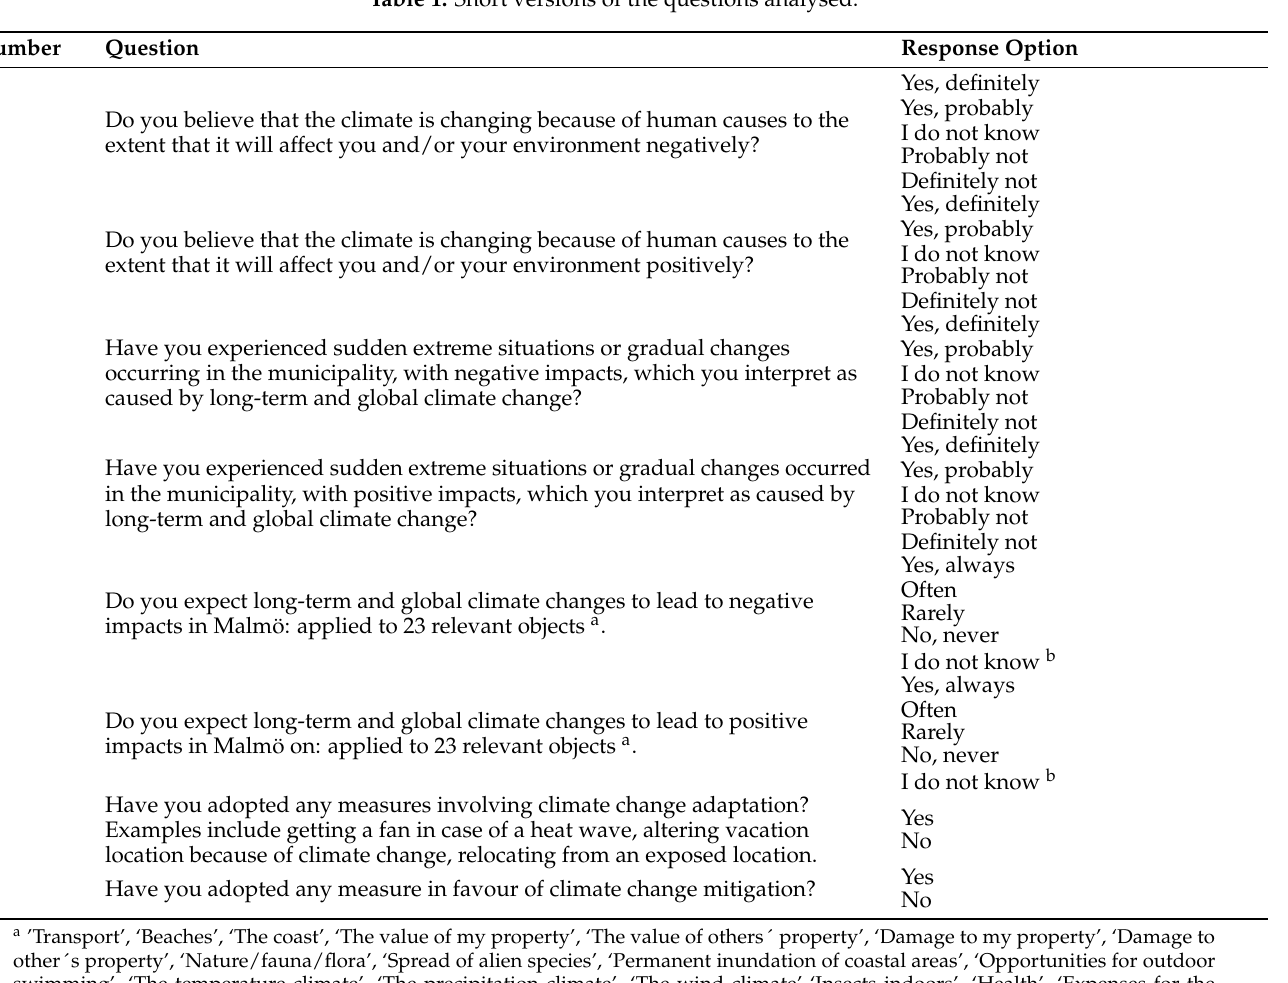
Table 1. Short versions of the questions